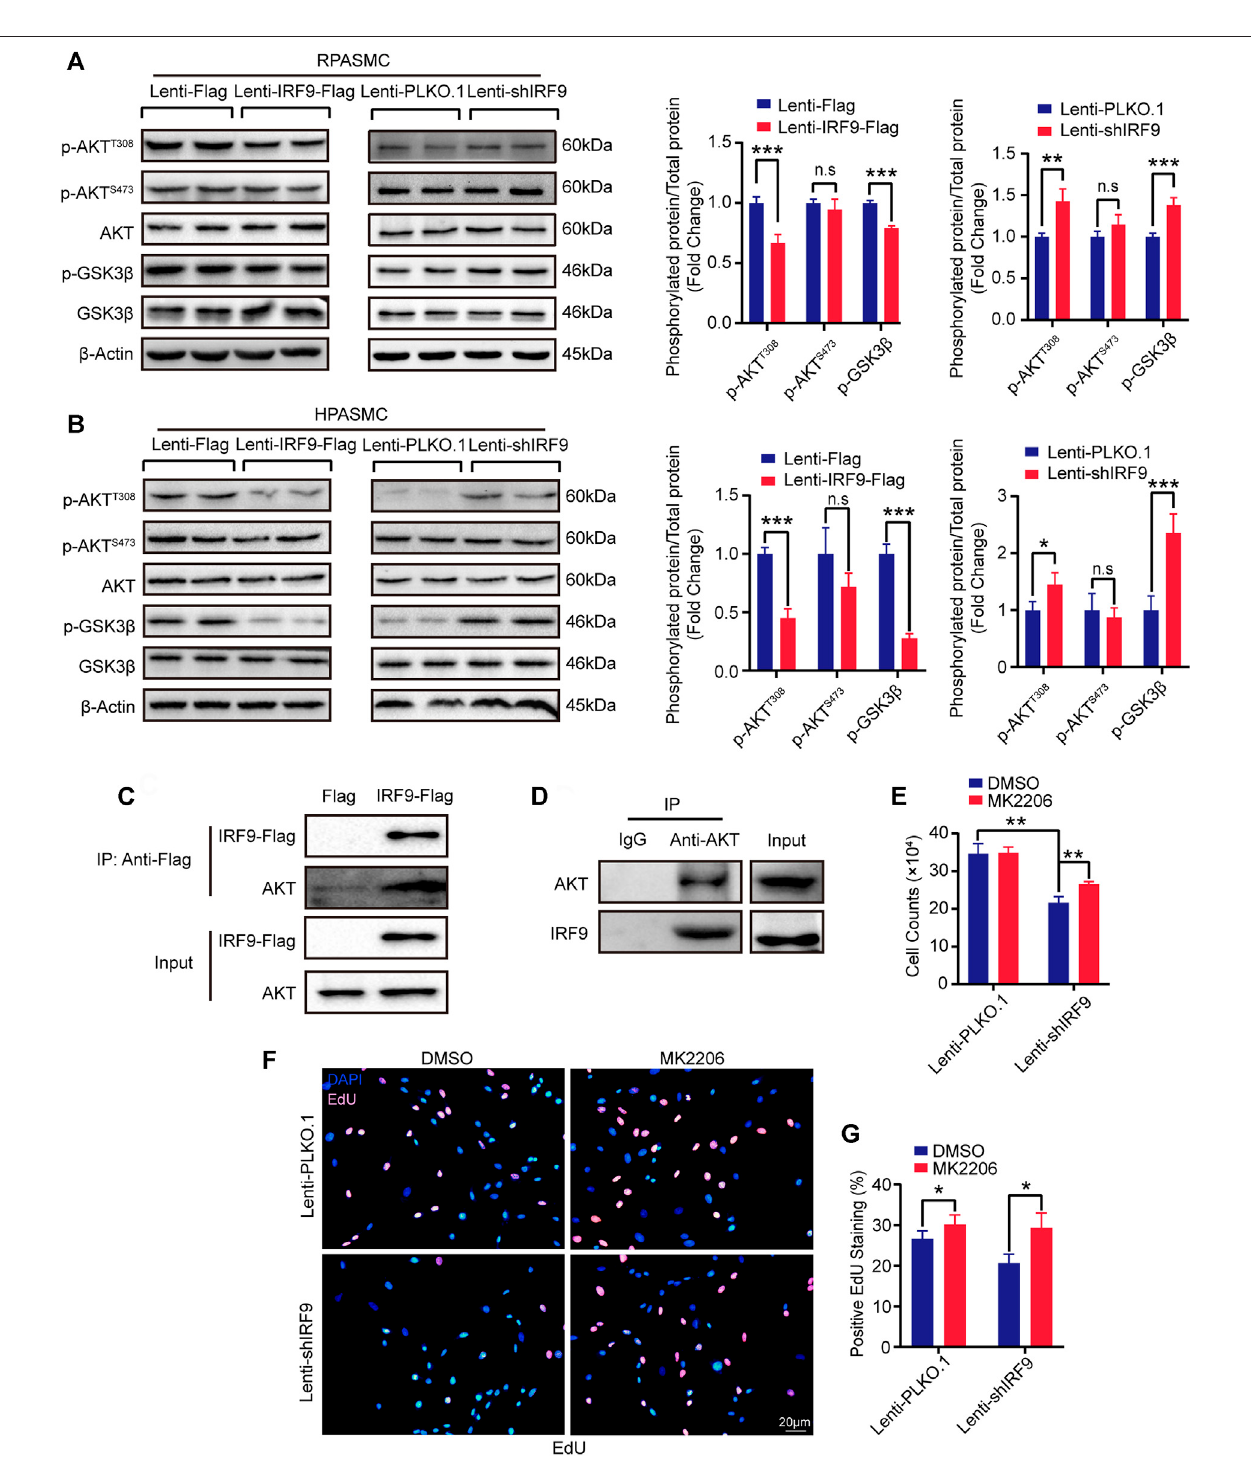
FIGURE5| IRF9regulatesPASMCproliferationthroughtheAKT/GSK3 β pathway. (A,B) Representativewesternblots (leftpanel) andquanti fi cationresults (right panel) of p-AKT T308 , p-AKT S473 , AKT, p-GSK3 β and GSK3 β in IRF9-overexpressed (Lenti-IRF9-Flag) or knocked down (Lenti-shIRF9) RPASMCs (A) and HPASMCs (B) under normoxia condition. The relative levels of phosphorylated proteins were normalized by their total protein respectively ( n (cid:2) 3 independent experiments). β -Actin serves as loading control. (C,D) Co-immunoprecipitation results show that exogeneous IRF9 interacts with endogenous AKT (C) and that endogenous AKT interacts with endogenous IRF9 (D) in HPASMCs. (E – G) The cell counts (E) , EdU incorporation staining (F) and quanti fi cation (G) of RPASMCs with IRF9 knockdown (Lenti-shIRF9) or not (Lenti-PLKO.1) treated with MK2206 (AKT phosphorylation inhibitor, 0.5 μ M, 48 h) or DMSO; the nuclei were stained with DAPI (blue) and incorporated EdU merged with DAPI appears pink (F) ( n (cid:2) 3 independent experiments). Values are means ± SD; *** p < 0.001, ** p < 0.01, * p < 0.05, n.s indicates non signi fi cance.